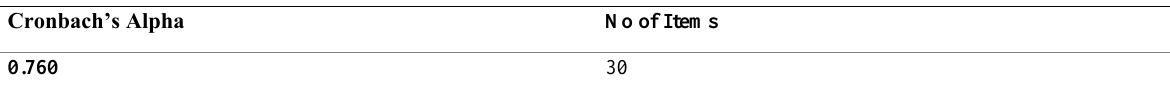
Table 1 : Reliability